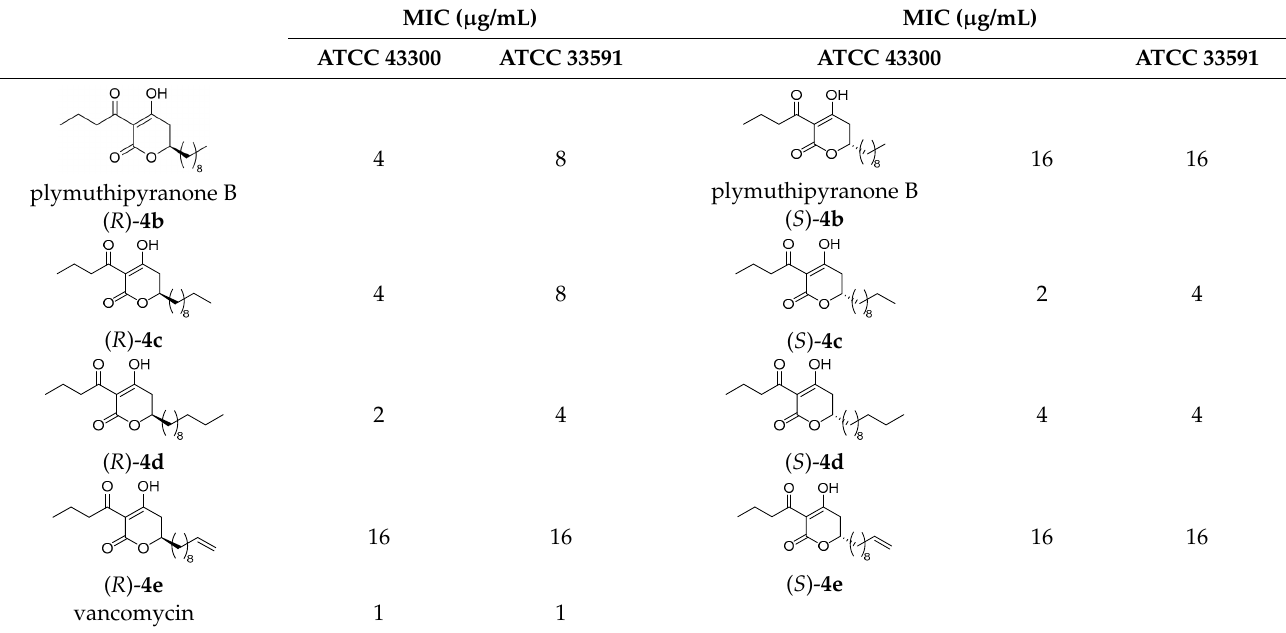
Table 1. Susceptibility testing all four pairs against ATCC 43300 and ATCC 33591. MIC (µg/mL)